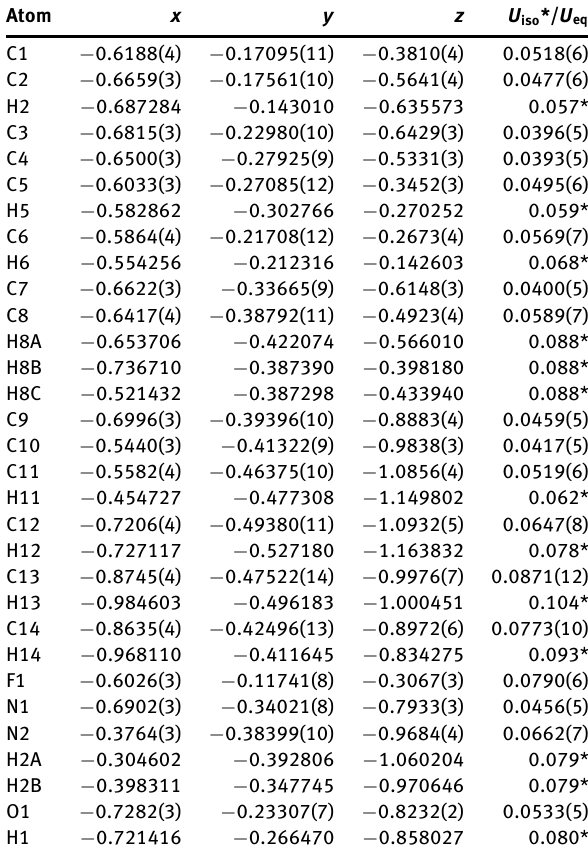
Table 2: Fractional atomic coordinates and isotropic or equivalent isotropic displacement parameters (Å 2